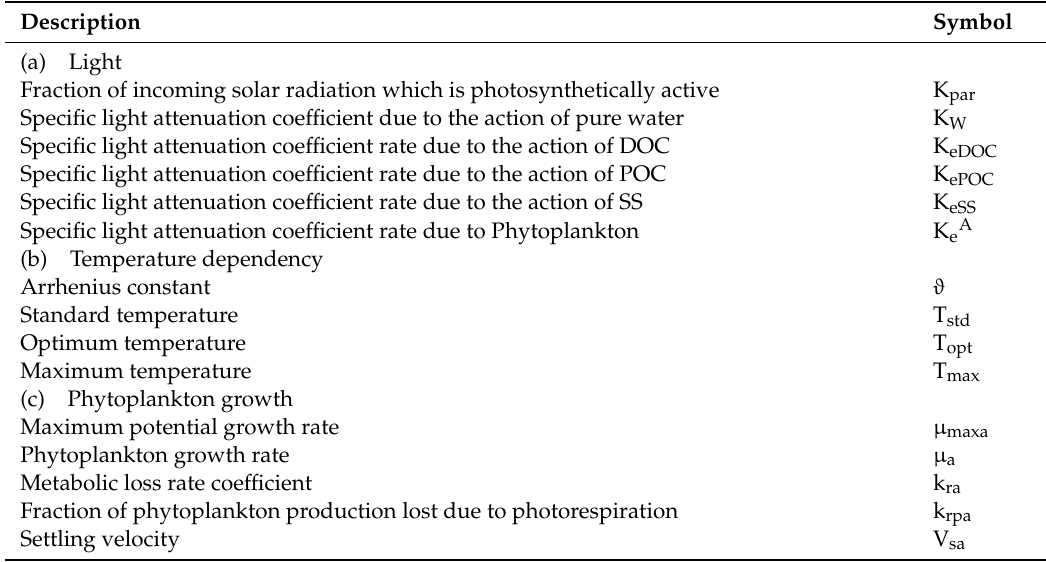
Table A5. Description of CAEDYM parameters for phytoplankton modelling. A is related to phytoplankton